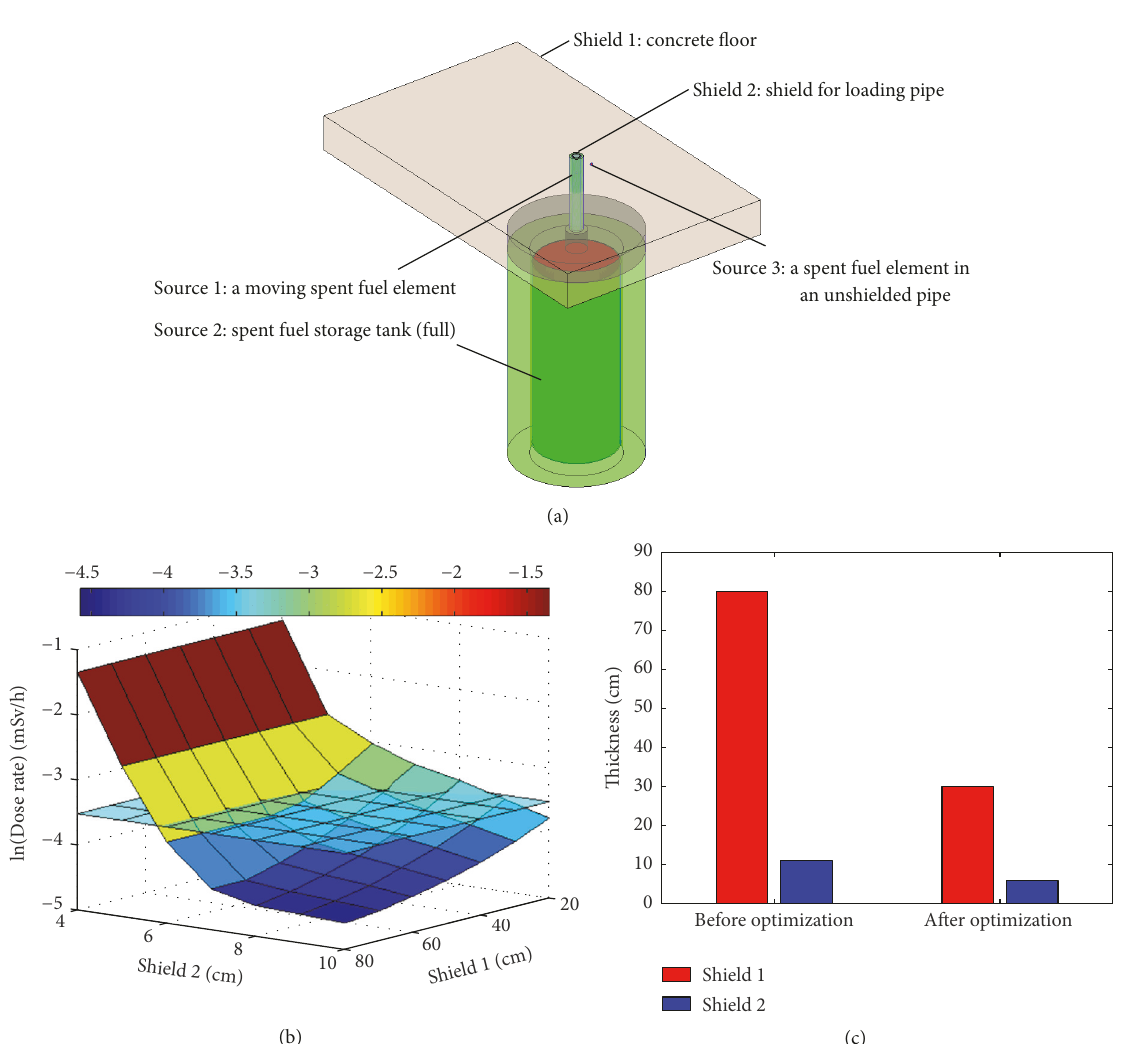
Figure 7: The optimization of the concrete floor and the shielding for the loading pipe. (a) The radiation computation model generated by the in-house tool; (b) dose rate contour and dose limit (the transparent plane); (c) the comparison between the designs before and after